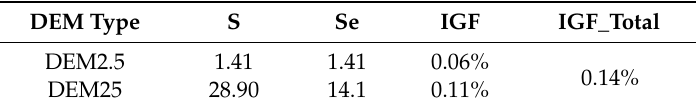
Table 2. Modeling results for S and IGF